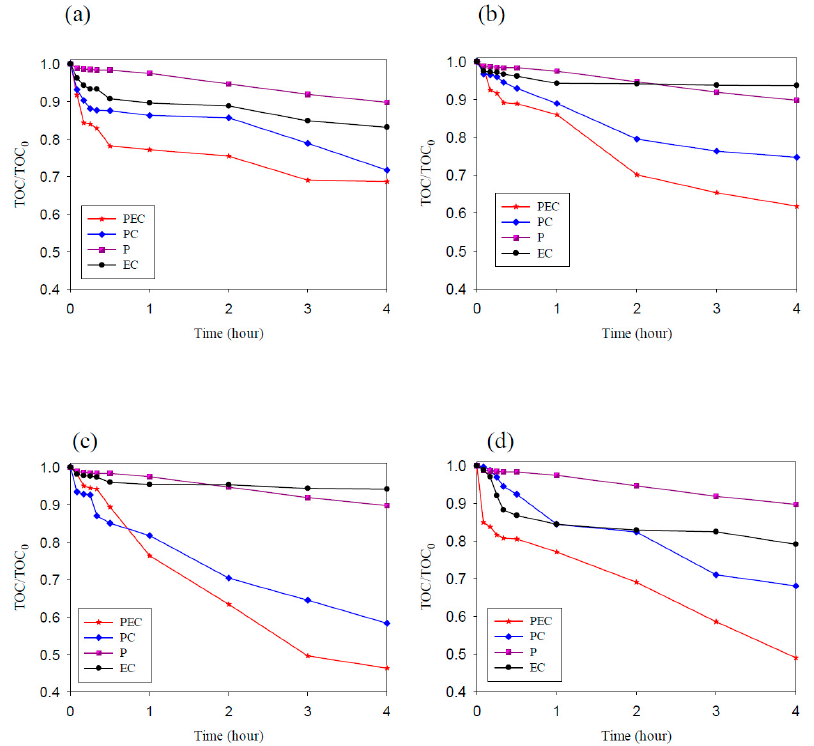
Figure 9. The removal rate of total organic carbon (TOC) by degrading methyl orange ( a ) TNAs, ( b ) Pd/TNAs, ( c ) Pd/TNAs-C, and ( d ) Pd/TNAs-G.